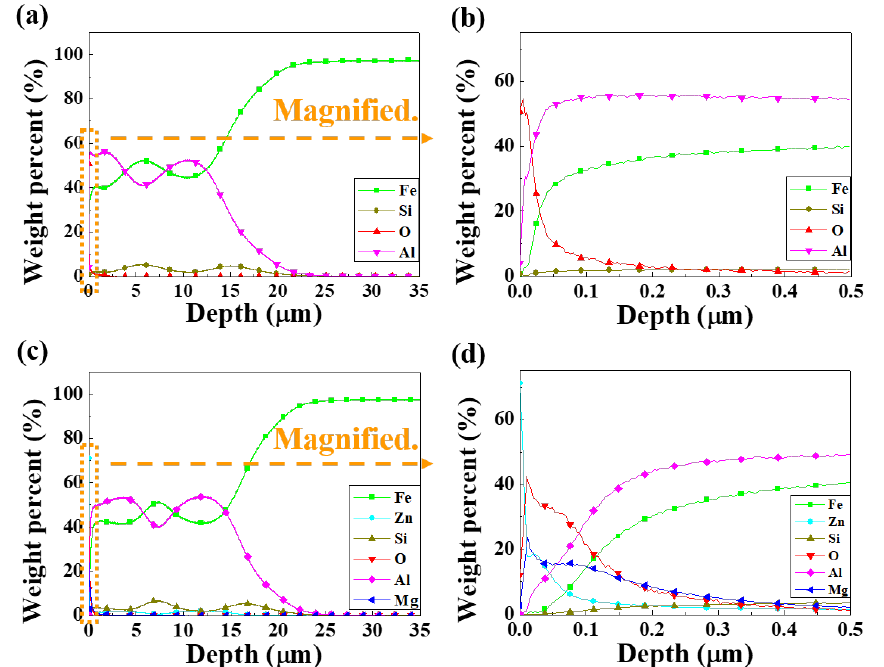
Figure 2. Glow discharge spectroscopy (GDS) depth profile of the coating layers: ( a , b ) AlSi-MC, ( c , d ) AlSiZnMg-MC.